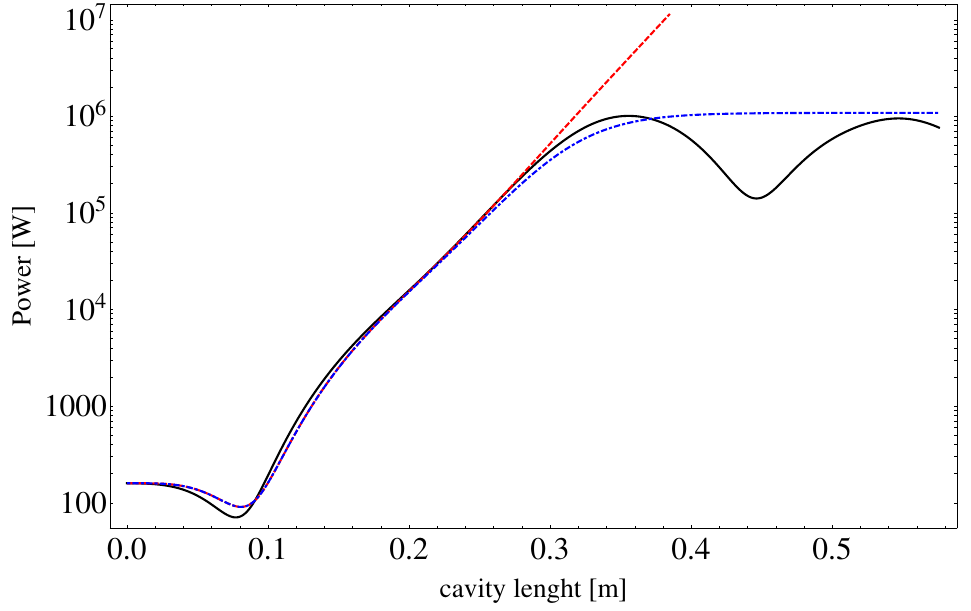
Figure 8. Numerical simulation of the CARM growth signal (continuous line), analytical solution (dashed line) with the logistic curve (dot-dashed line) reproducing the saturation. The simulation was performed with a beam energy of 700 keV, current 60 A and pitch factor α = v ⊥ / v || = 5.3 interacting at the resonance frequency of 260 GHz with the mode TE 53 of a cylindrical tube with radius of 7.5 mm embedding an on-axis field of intensity B 0 = 5.3 T. An input signal of 130 W was used to seed the CARM